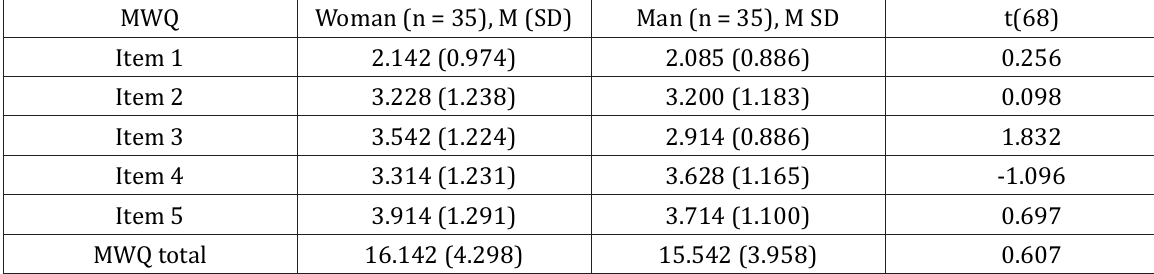
dispersion.Table Figure 1. The empirical distribution of Polish MWQ total score results with the curve representing expected normal Table 2. Comparison of Polish MWQ version results in studied men and